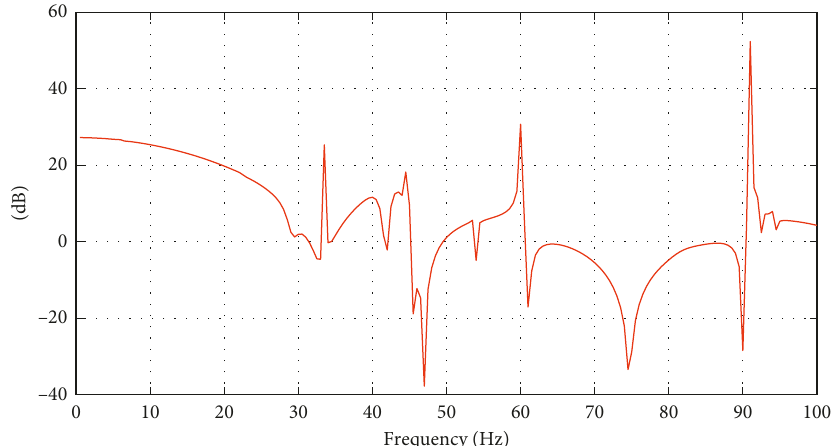
Figure 16: FEM Transmissibility between lower and upper platen.